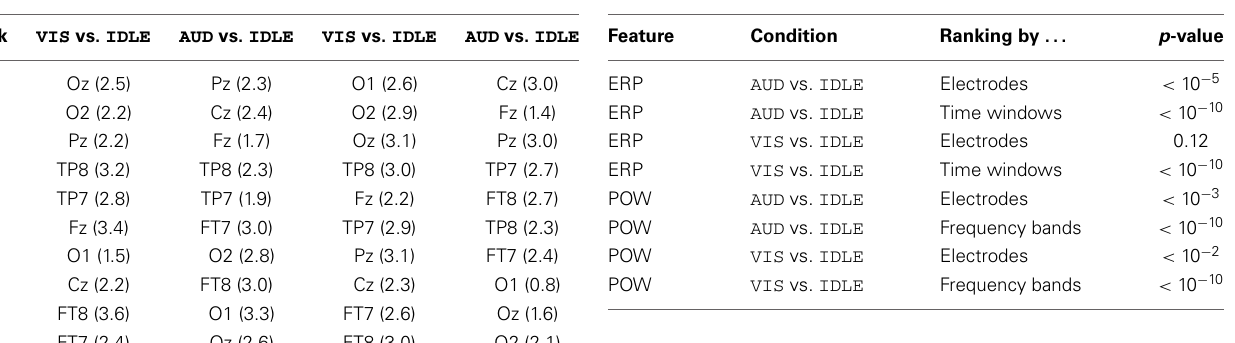
Table 6 | Average rankings of electrode positions derived from correlation of POW and ERP features to ground truth labels.